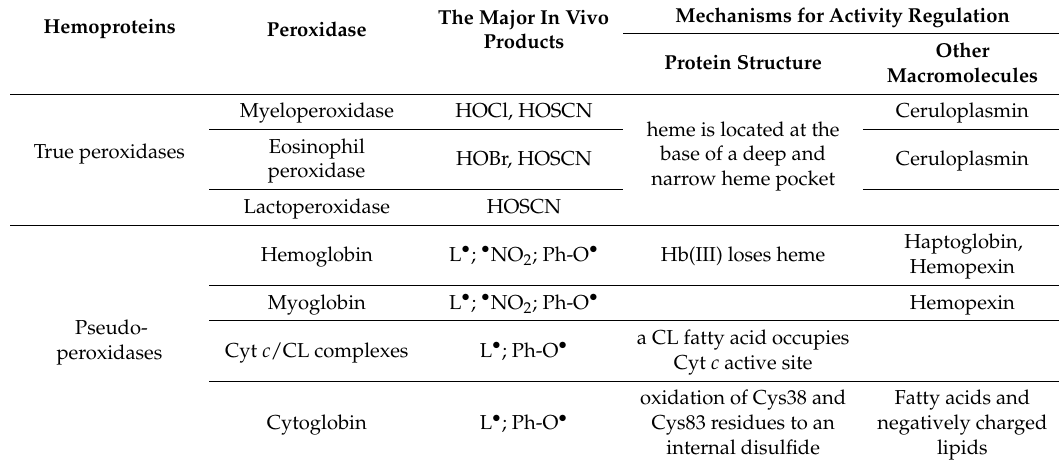
Table 3. The major mechanisms for regulation of peroxidase activity of hemoproteins.